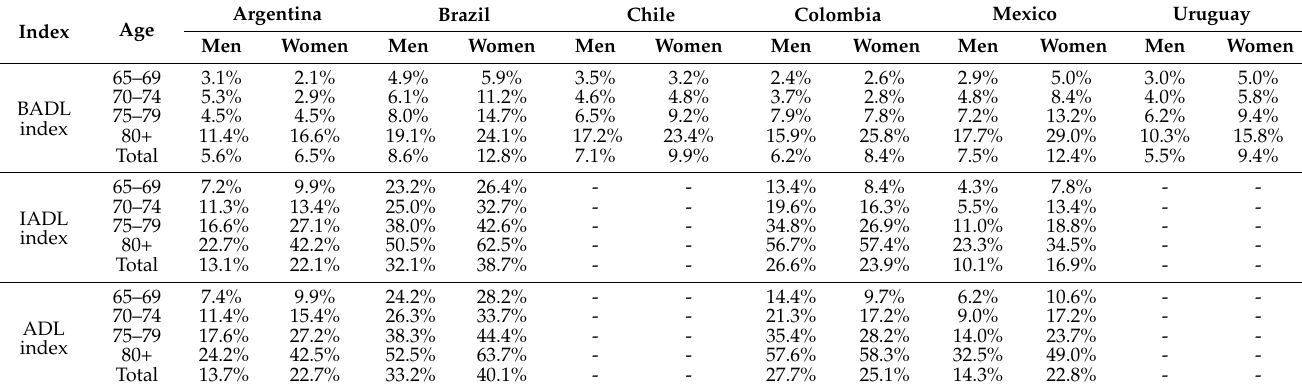
Table 7. Percentages of older adults (65+) who needs help to perform any BADLs, IADLs, or both (ADLs) by sex, age, and